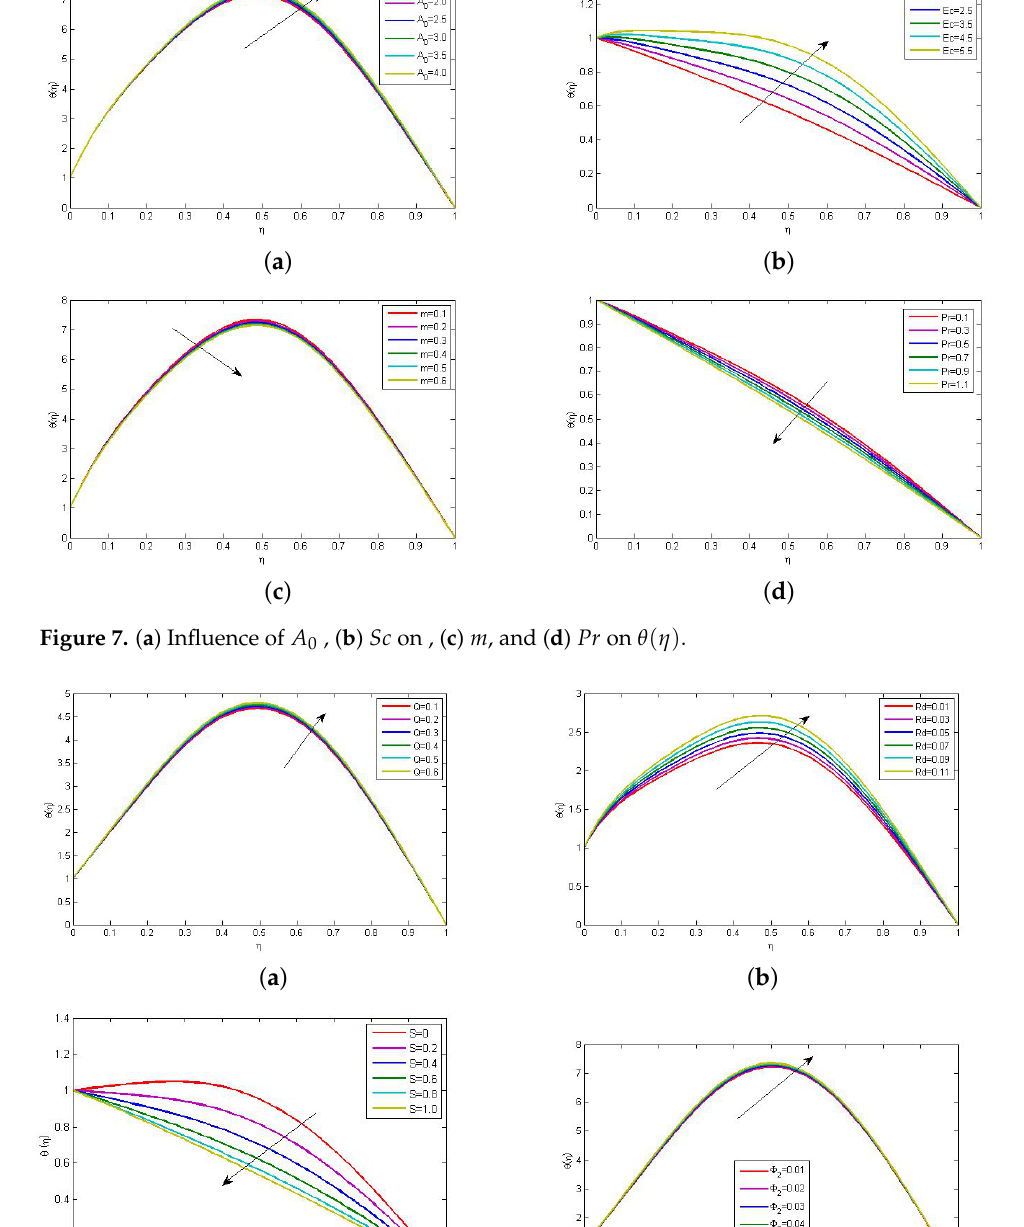
along the x-axis with the changing values x